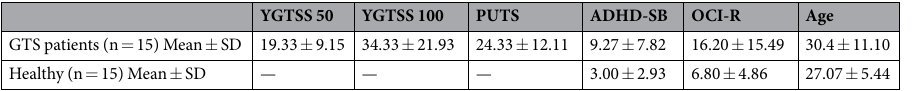
Table 1. Questionnaire data. Means and standard deviations (SD) of questionnaire data for patients and healthy controls. YGTSS = Yale Global Tic Severity Scale; PUTS = Premonitory Urge for Tics Scale; ADHD-SB = attention deficit hyperactivity disorder self-rating scale; OCI-R = obsessive-compulsive disorder scale revised.